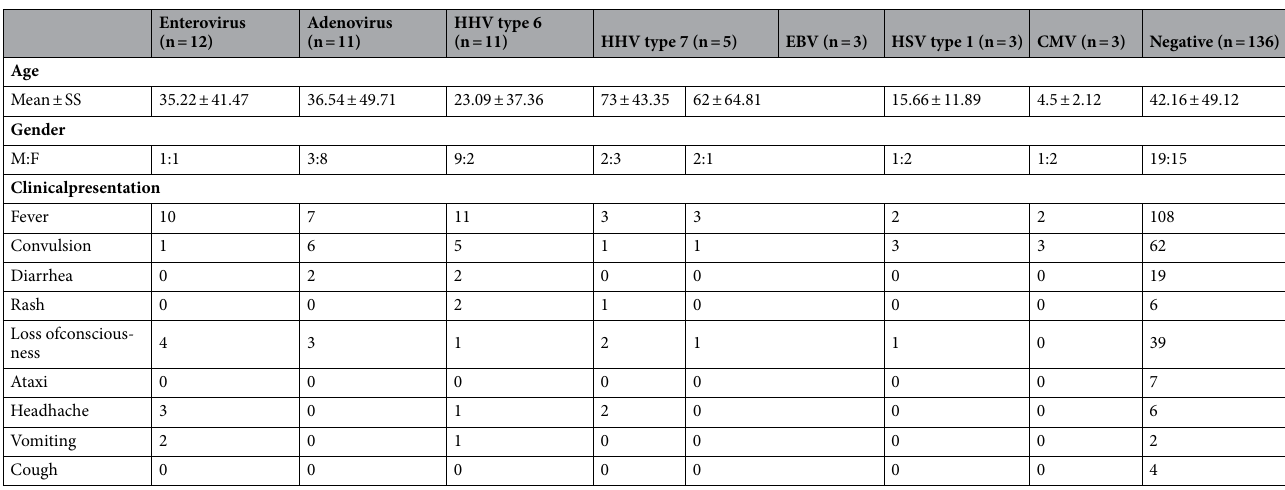
Table 1. Distribution of age, gender and clinical presentations according to viral panel results. HHV Human Herpes Virus, CMV Cytomegalovirus, HSV Herpes Simplex Virus, EBV Ebstein Barr